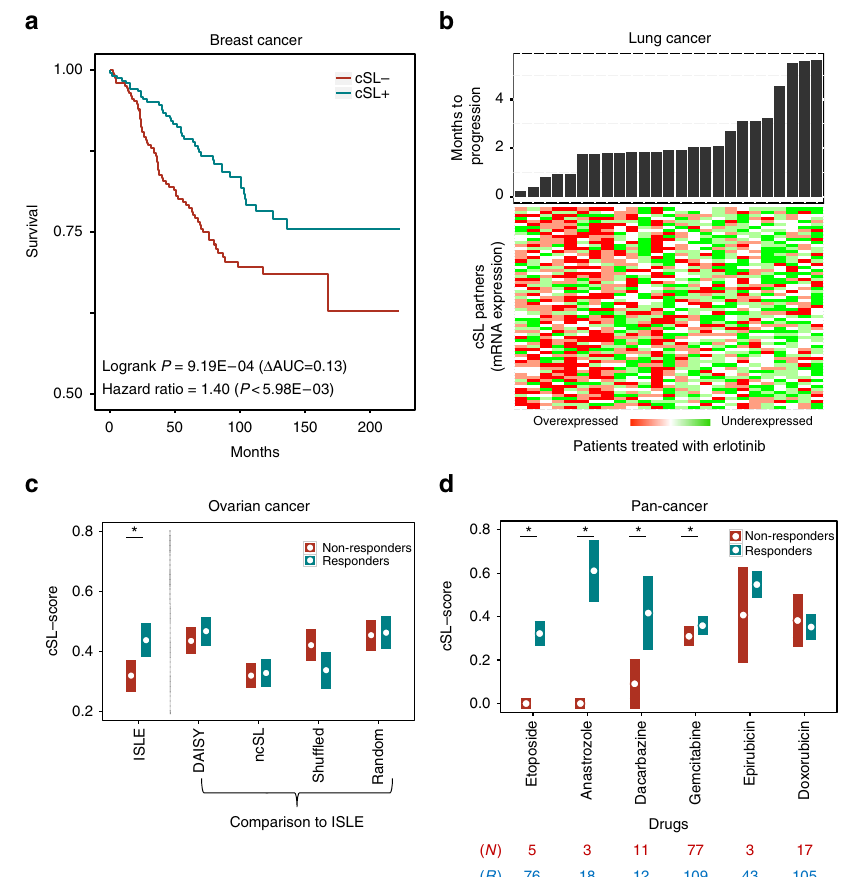
Fig. 4 Drug-cSL-network predicts treatment outcomes in cancer patients. a The KM plot of predicted responders (blue) vs non-responders (red) to taxane- anthracycline chemotherapy 64 . We divided the patients into responders vs non-responders based on the median value of their cSL-scores. b The gene expression of the cSL partners in patients treated with erlotinib 65,66 , ordered according to their months-to-progression (on-top). As predicted, patients with many downregulated cSL partners progressed slower. c The responders (blue) to taxane-cisplatin therapy for ovarian cancer show signi fi cantly higher ISLE cSL-scores than the non-responders (red) (Wilcoxon rank sum P < 9.1E-3). The X -axis shows the different groups of partners studied, and Y -axis provides their cSL-scores in responders vs non-responders. d TCGA patients with a large number of downregulated drug-cSL partners in their tumors show better response based on RECIST criteria. X -axis shows six drugs that have considerable (>12 samples) drug response information in TCGA, and Y -axis represents the cSL-score (divided by total number of SL partners to guide visualization, mean and s.e.m) of their drug targets, where cancer types are controlled for (* marks the four drugs that are signi fi cantly predicted after multiple hypothesis corrections (FDR-corrected Wilcoxon rank sum P < 0.2, and epirubicin FDR < 0.23), drugs are listed in order of signi fi cance). Blue (red) bars denote the cSL-scores of the responders (non-responders), and the numbers marked in blue (red) below the fi gure indicate the number of responders (non-responders) for each drug. All the analyses were performed using the drug-cSL-network (presented in Supplementary Fig. 8) based on the drug-target mapping available listed in Supplementary